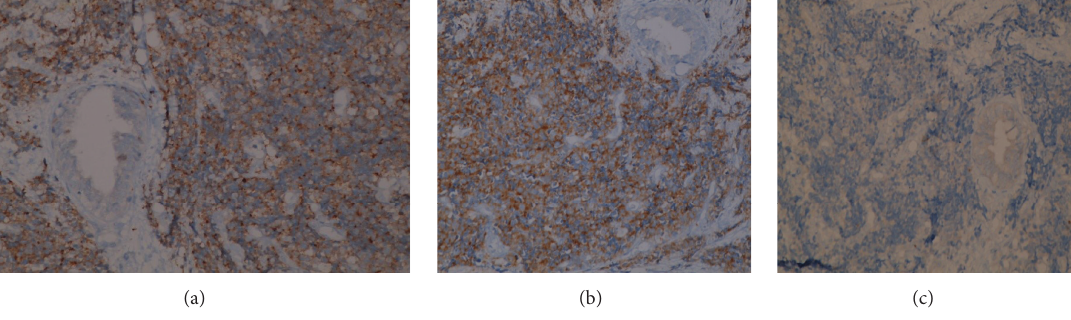
Figure 2: (a) IHC with synaptophysin: strongly positive. (b) IHC with CD 56: strongly positive in the NEC component. (c) IHC with chromogranin: